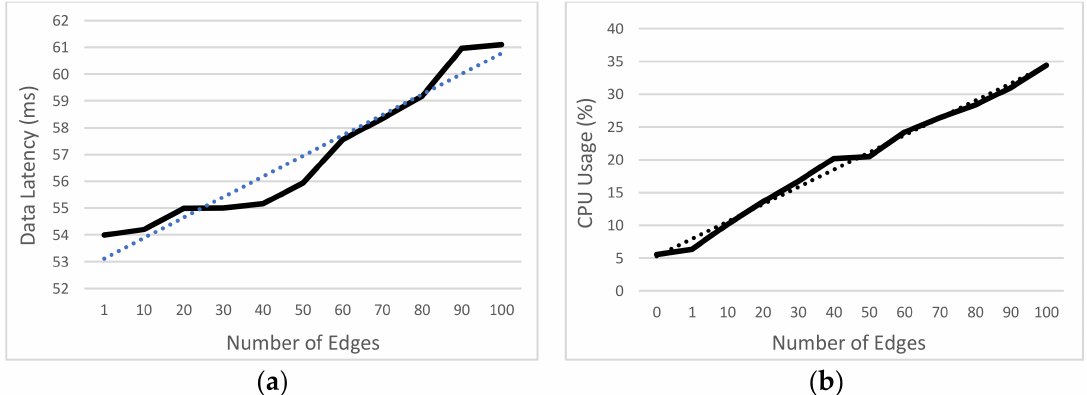
Figure 12. Changes in data latency and CPU usage according to the number of edges. ( a ) Data latency performance evaluation. ( b ) CPU usage performance